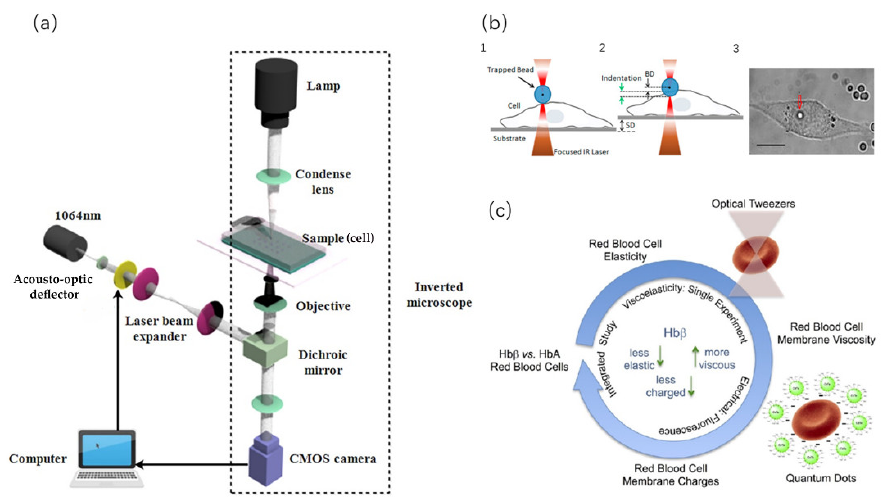
Figure 4. ( a ) Experimental devices of optical tweezers; ( b ) schematic diagram and experimental image of indentation experiment; ( c ) measurement of viscoelasticity and membrane charge of erythrocytes. (Adapted by kind permission from [112]).